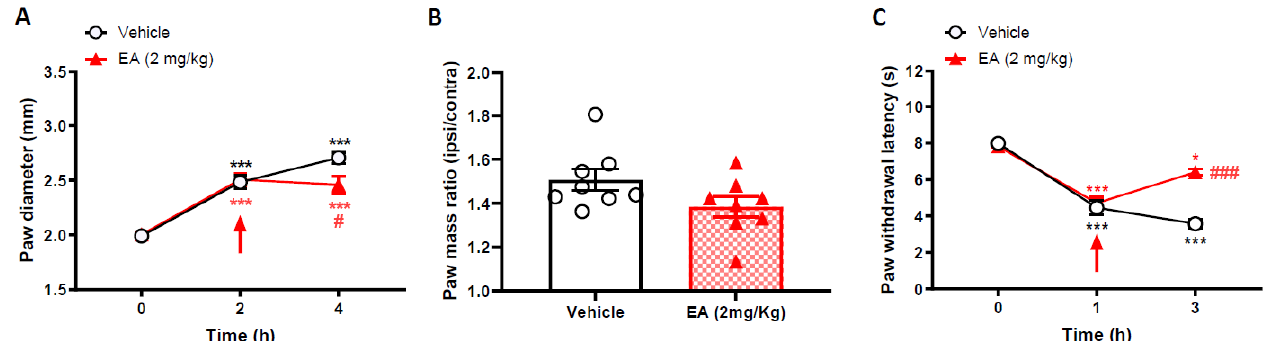
Figure 2. Englerin-A reverses carrageenan-induced paw oedema and thermal hyperalgesia when given 2 h after carrageenan. ( A ) Time-course of paw oedema measured by callipers and ( B ) ipsilateral/ contralateral paw mass ratio, 4 h following induction of paw oedema by 2% Carrageenan. Data are mean ± S.E.M, n = 6–8. *** p < 0.001 versus baseline, # p < 0.05, versus vehicle, Two-way RM ANOVA, post-hoc Tukey test. ( C ) Thermal paw withdrawal thresholds measured at 1 and 3 h, respectively, after intra-plantar injections of carrageenan. Arrow indicates time of EA treatment (2 mg/kg i.p.). * p < 0.05, *** p < 0.001 versus baseline, ### p < 0.001 versus vehicle, Two-way ANOVA, post-hoc Tukey test. Data are mean ± S.E.M, n = 6–8.